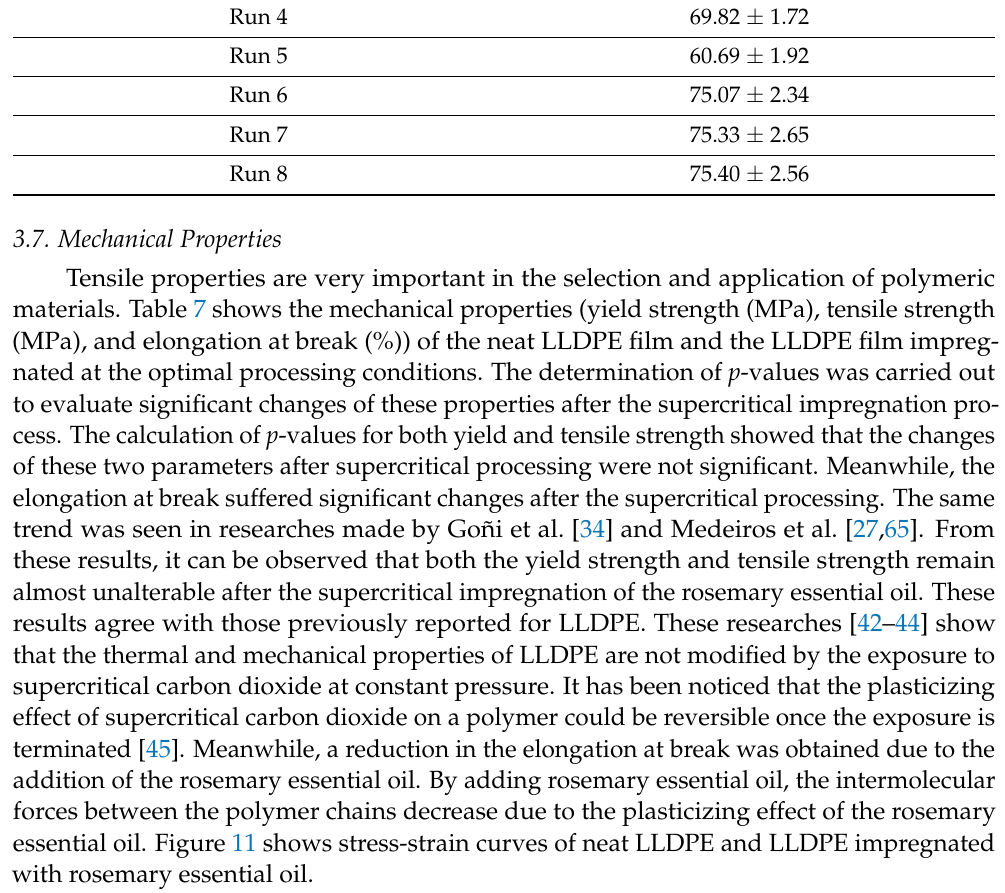
Table 7. Mechanical properties of the neat LLDPE film, and impregnated LLDPE film.